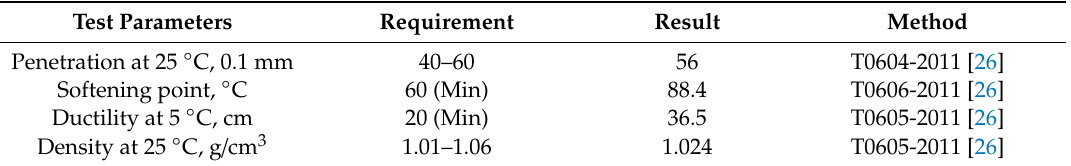
Table 3. Basic performance of the styrene–butadiene–styrene (SBS) modified asphalt binder.